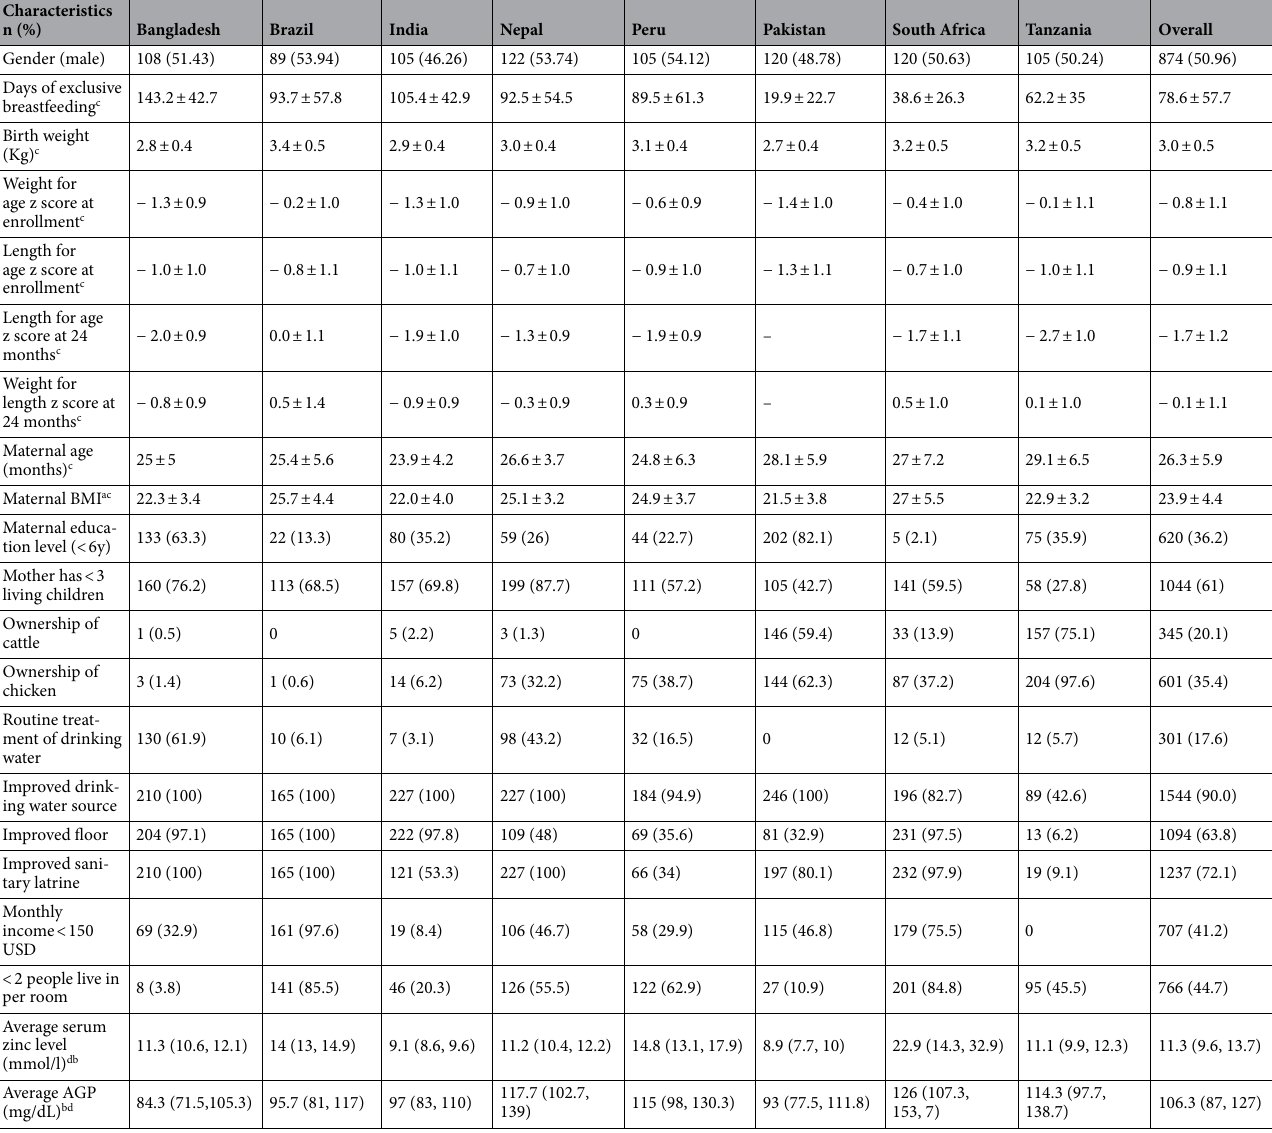
Table 1. General characteristics of the MAL-ED study children (n = 1715) from Bangladesh, India, Nepal, Pakistan, South Africa, Tanzania, Brazil, and Peru from November 2009 to February 2012. a BMI: